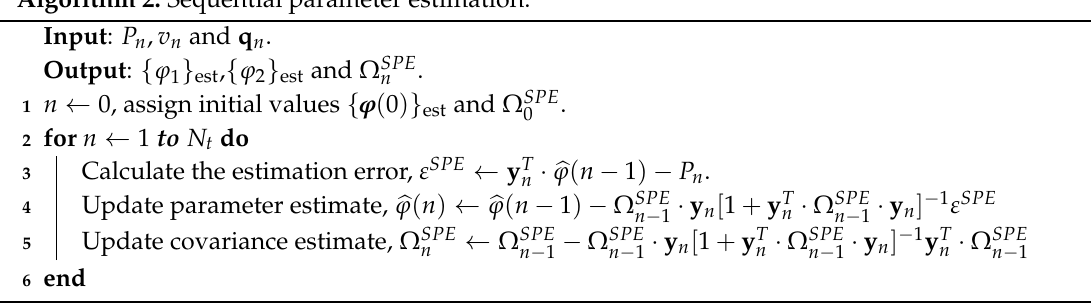
Algorithm 2: Sequential parameter estimation.